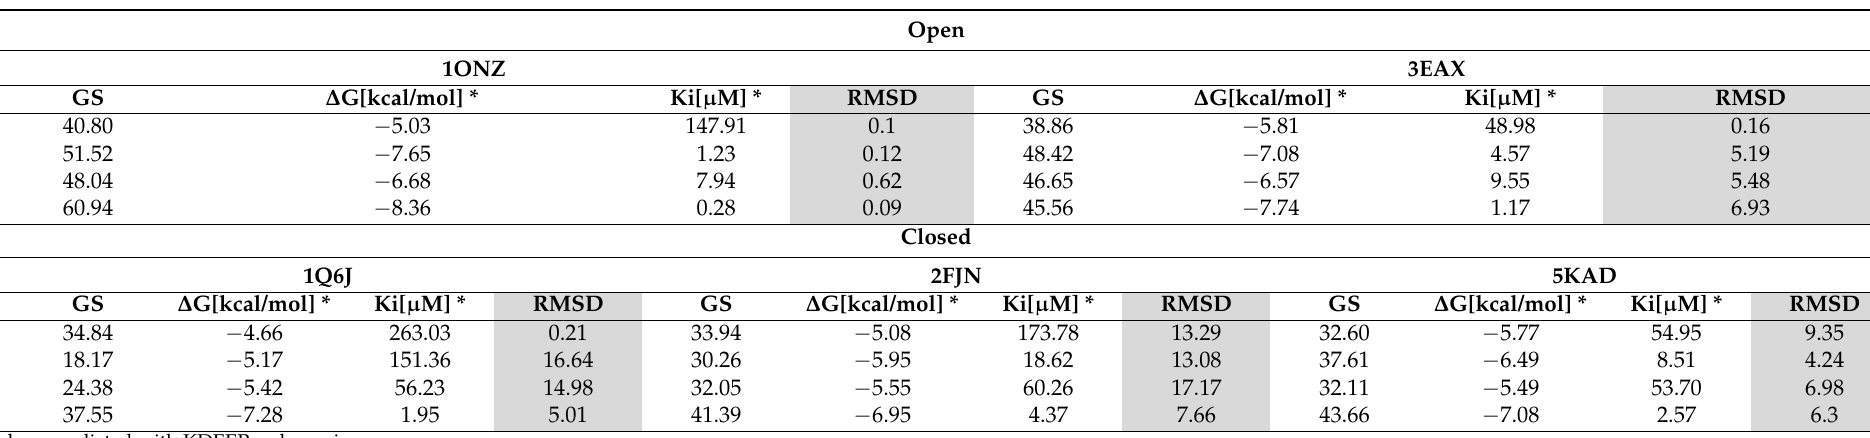
Table 2. GoldScore (GS) values, predicted ∆ G [kcal/mol], Ki [ µ M] and mean RMSD (gray column) for Compounds 1 – 4 docked to complexes with WPD-loop in open and closed